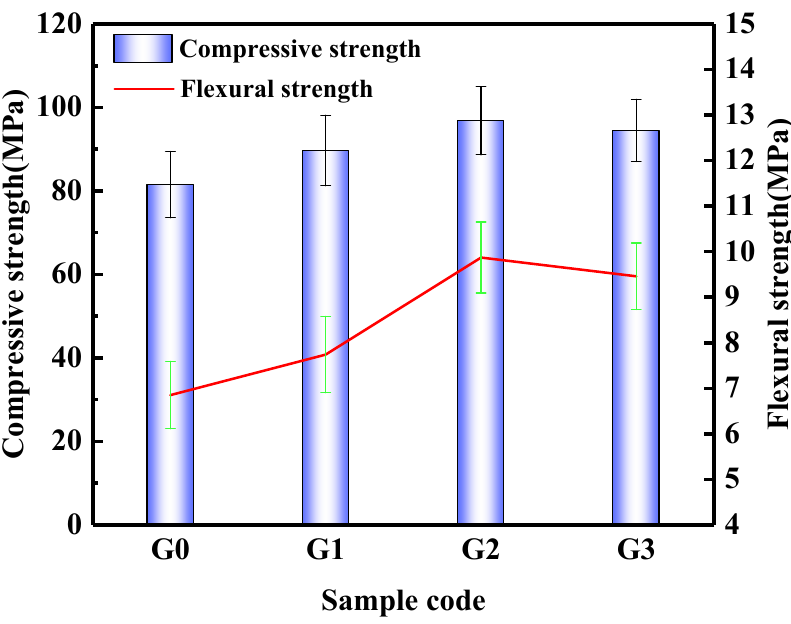
Figure 6. Macro performance of SAC paste.